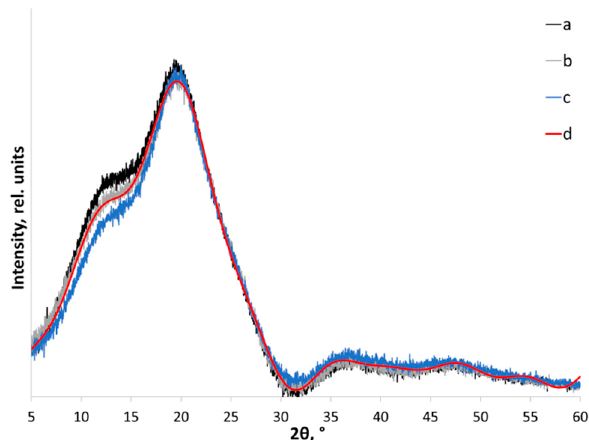
Figure 5. X-ray powder diffraction patterns of high (a), medium (b), low (c) MW chitosan after mechanical amorphization for 1200 s, and (d) amorphous profile approximated by the eighth-order Fourier model (“universal amorphous standard”).